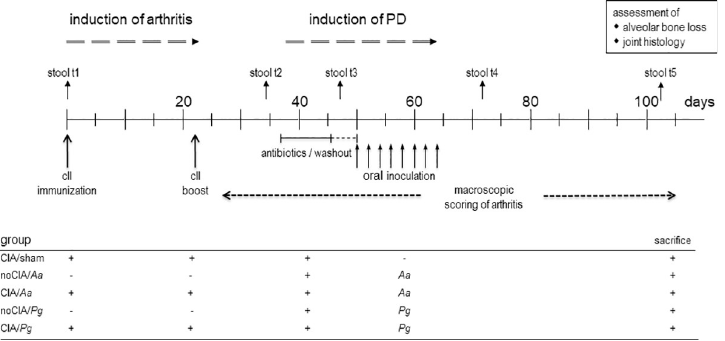
Fig 6. The experimental setup of CIA induced before PD. Periods for antibiotics treatment and macroscopic scoring of arthritis are indicated by horizontal lines and arrows, while individual days for immunization, boost, oral application of the pathobionts, as well as stool sampling are shown by vertical arrows. Experimental endpoint was day 105 and assessments of alveolar bone loss and joint histology were only made thereafter. Tables below the graphs summarize the individual experimental groups. Pg : Porphyromonas gingivalis ; Aa : Aggregatibacter actinomycetemcomitans ; sham: oral inoculation with PBS/ sodium carboxymethylcellulose.